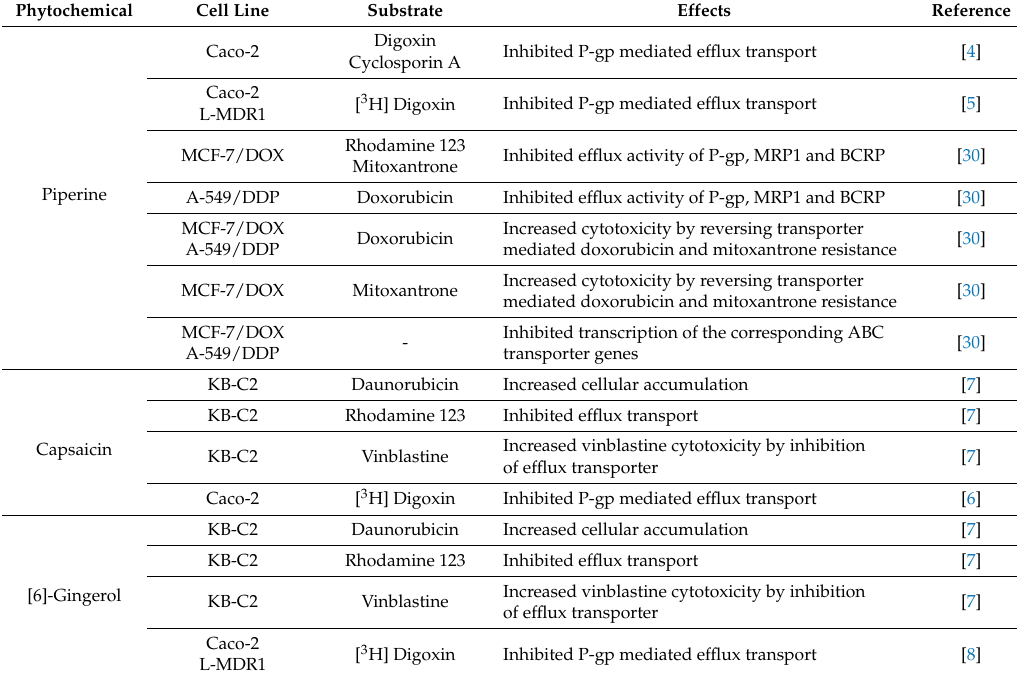
Table 1. Effects of phytochemicals on the P-gp mediated transport in